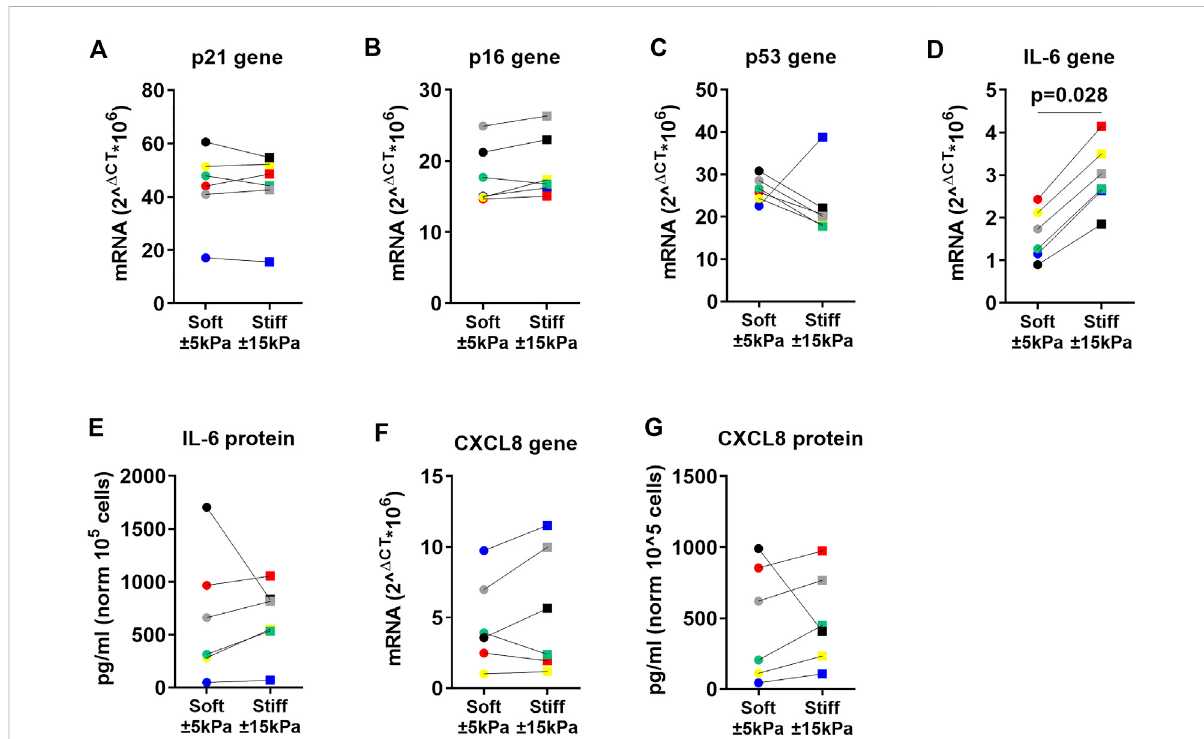
FIGURE 6 Primary human lung fi broblasts exhibit an activated and pro fi brotic phenotype on stiff (11.34 ± 3.82 kPa) compared to soft (3.94 ± 0.87 kPa) hydrogels. To characterise the fi brotic response of fi broblasts on hydrogels, gene expression levels for fi broblast activation α -SMA and matrix proteins COL1 α 1, FN1, LOX, FBLN1 and FBLN1C were measured at day 7 (A – F) . Finally, deposited FBLN1 (Red) was stained using fl uorescent labelled antibodies and DAPI for identi fi cation of cell nuclei in panel (G) . Illustrated photographs are representative images of in total 7 donors. Differences between soft and stiff hydrogels were analysed by a Wilcoxon matched pairs signed rank test ( n = 6). Scale = 50 µm. Each donor has a different unique colour (blue, red, yellow, green, black, and